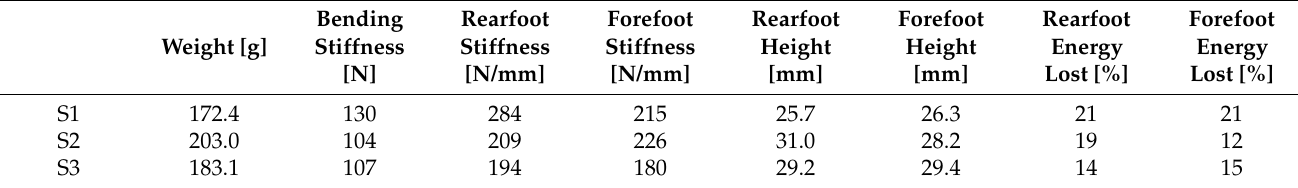
Table 1. Characteristics of shoe conditions for men’s size